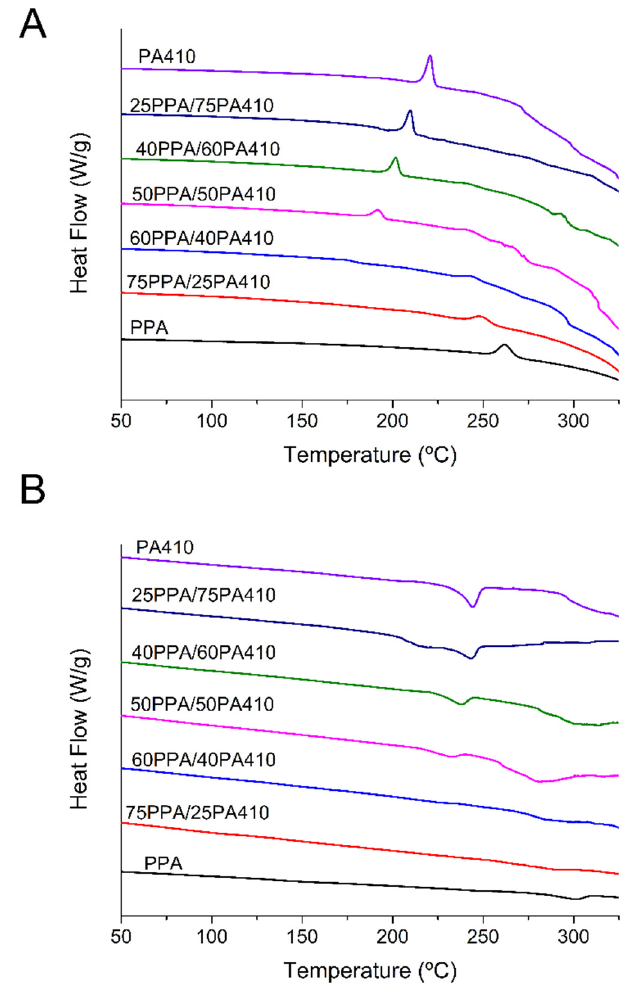
Figure 3. DSC curves of the PPA, PA410 and their blends: ( A ) first cooling cycle; ( B ) second heating cycle. Both cycles were measured at a rate of at 10 °C/min. Exotherms are up. In order to investigate their thermal behavior, Equation (2), was used to calculate the percentage crystallinity ( χ c ):